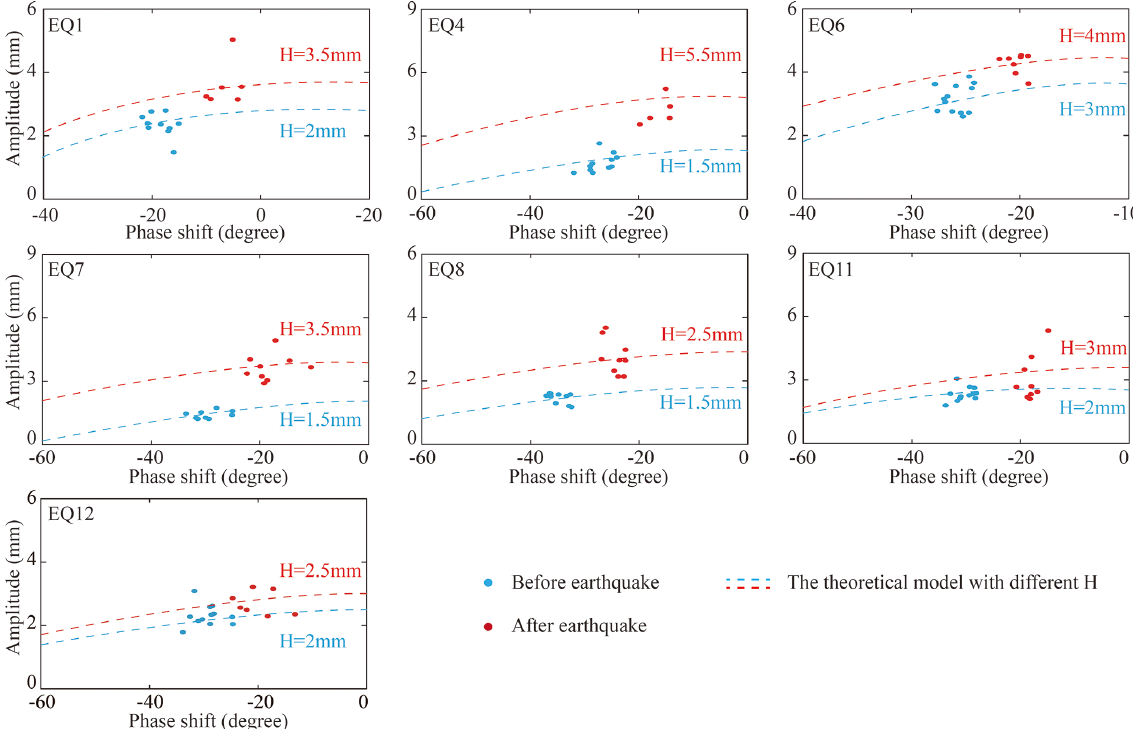
Figure 5. Amplitude versus phase shift at the frequency of the M 2 wave. Dots before earthquakes (blue dots) and after earthquakes (red dots) fit two curves that represent the theoretical model (Eqs. 2 and 3) with different values of H ,